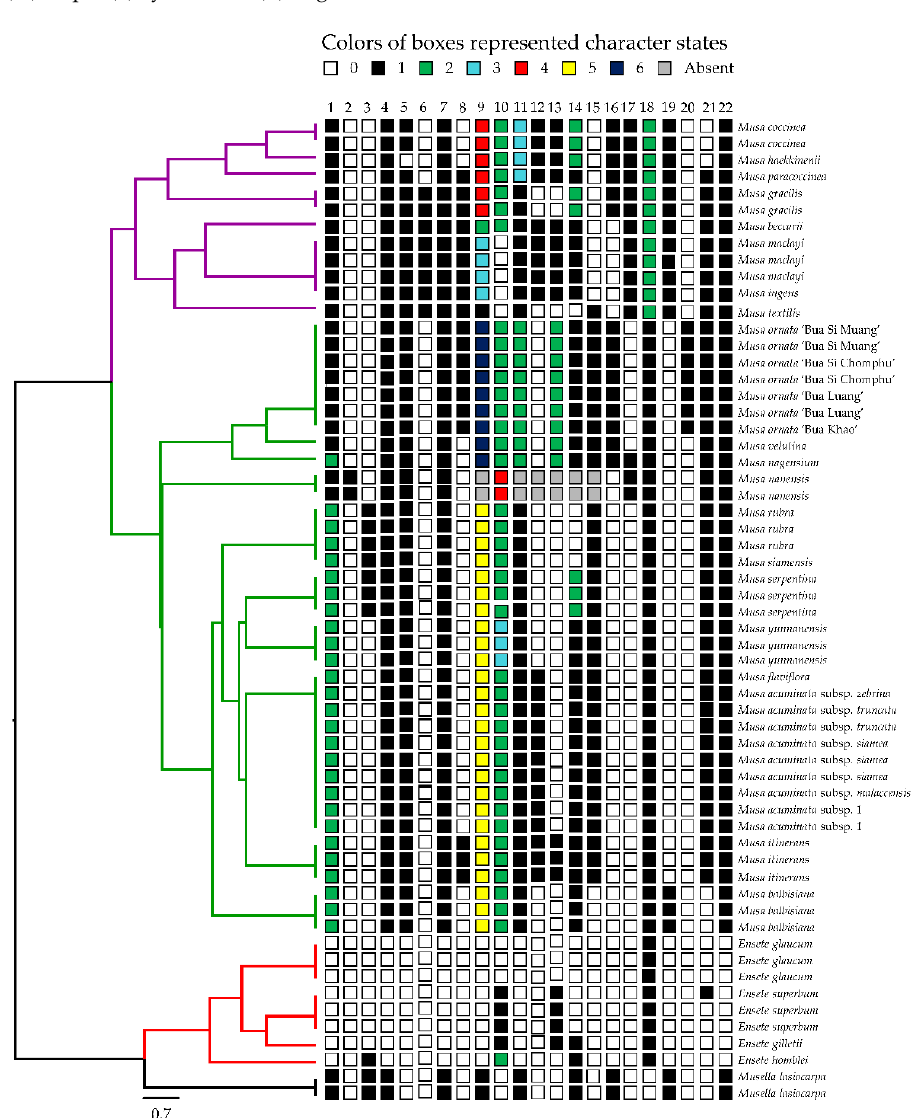
Figure 6. UPGMA dendrogram of 59 OTUs within Musaceae based on 22 floral morphological characters of male flowers (see details of the character states in Materials and Methods, character no. 1–8 in Figure 3; character no. 9–15 in Figure 4; character no. 17–21 in Figure 5; Table